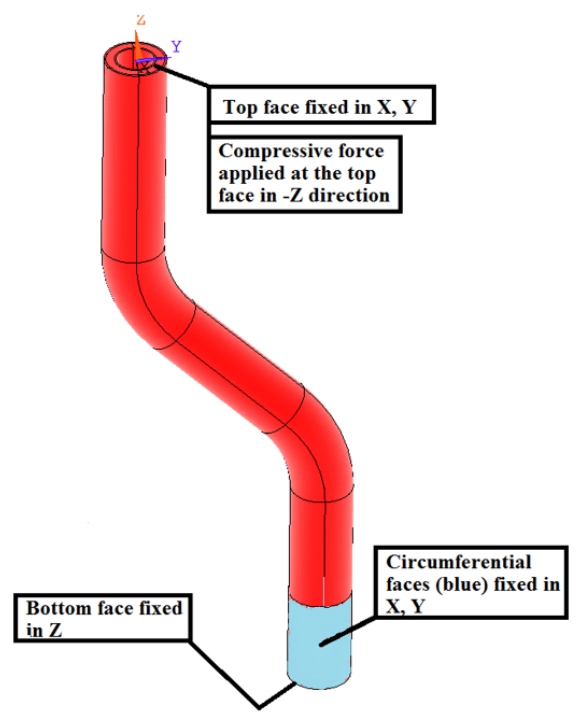
Figure 7. FEM analysis—boundary conditions.